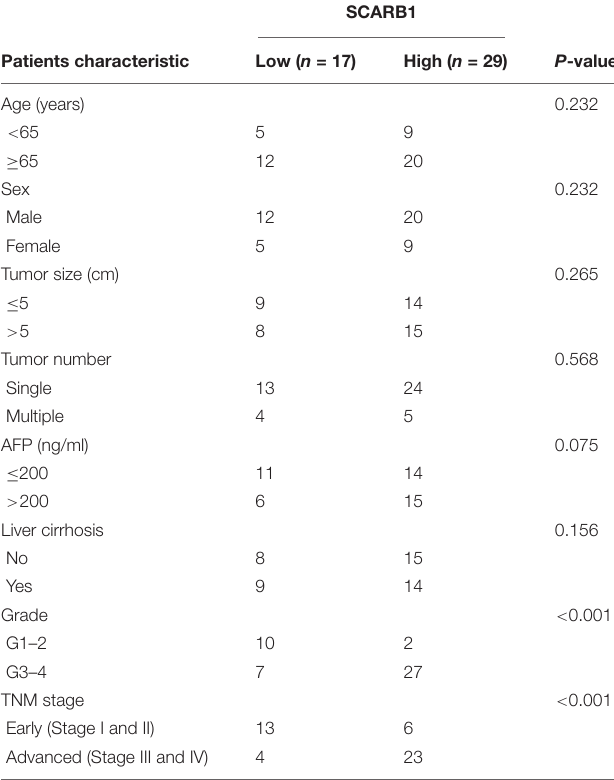
TABLE 2 | The correlation between SCARB1 and clinicopathological characteristics in HCC.